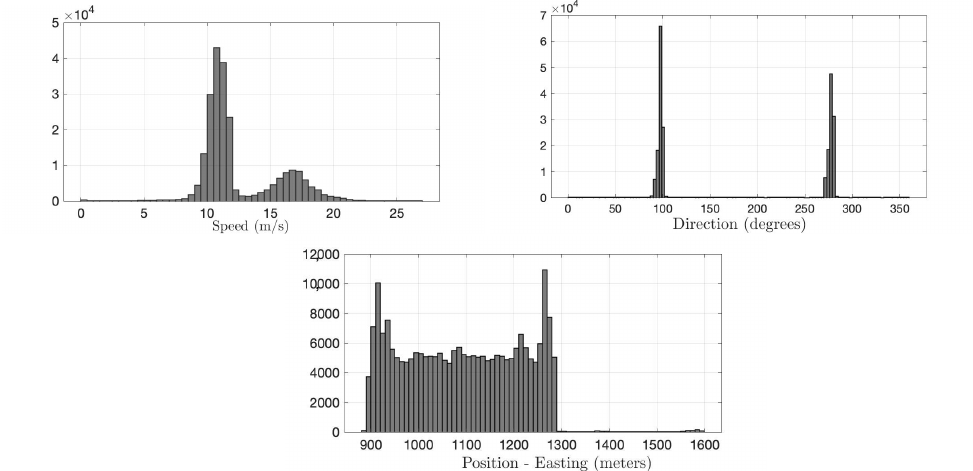
Figure 5. The heterogeneous probability distributions of message content in the Warrigal dataset. Histograms are obtained from the training